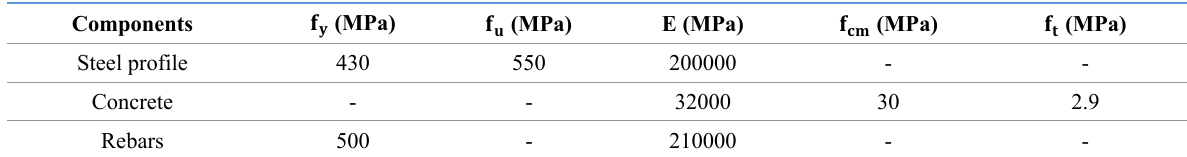
Table 2. Materials